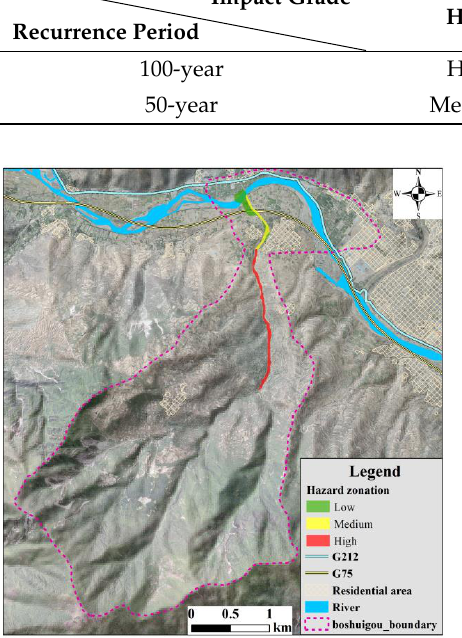
Table 6. Hazard assessment considering impact intensity and recurrence period.